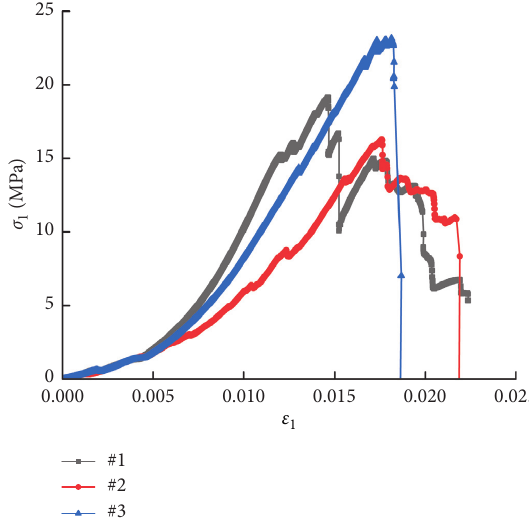
Figure 5: Stress-strain curves of the uniaxial compression